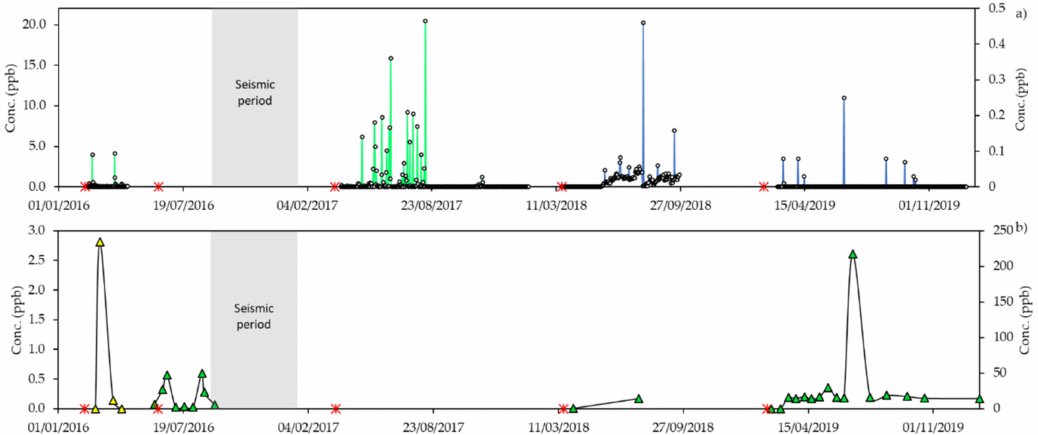
Figure 9. Tracer Breakthrough Curves of tests performed in the area starting from February 2016 (pre -seismic period) until December 2019. ( a ) Tracer recovered at the Castelsantangelo sul Nera linear spring (point 4 in Figure 2). The principal vertical axis refers to the green line, while the secondary vertical axis refers to the blue line. ( b ) Tracer concentration measured in punctual samples (point 5 in Figure 2). The principal vertical axis refers to the yellow symbols, while the secondary vertical axis refers to the green